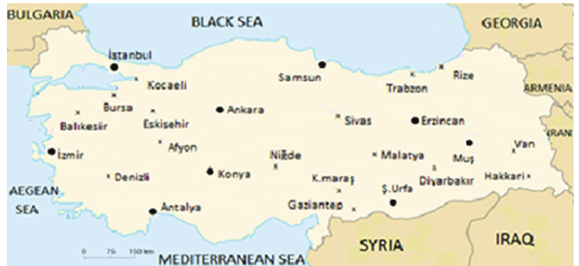
Figure 1: The geographical distributions of nine calibration ( ∙ ) and 16 testing (x) stations in